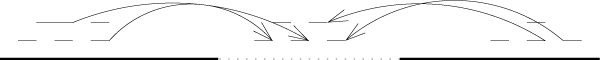
Scaffold gap removal. Unfilled gaps in scaffolds can be filled by re-mapping the reads onto the contigs.